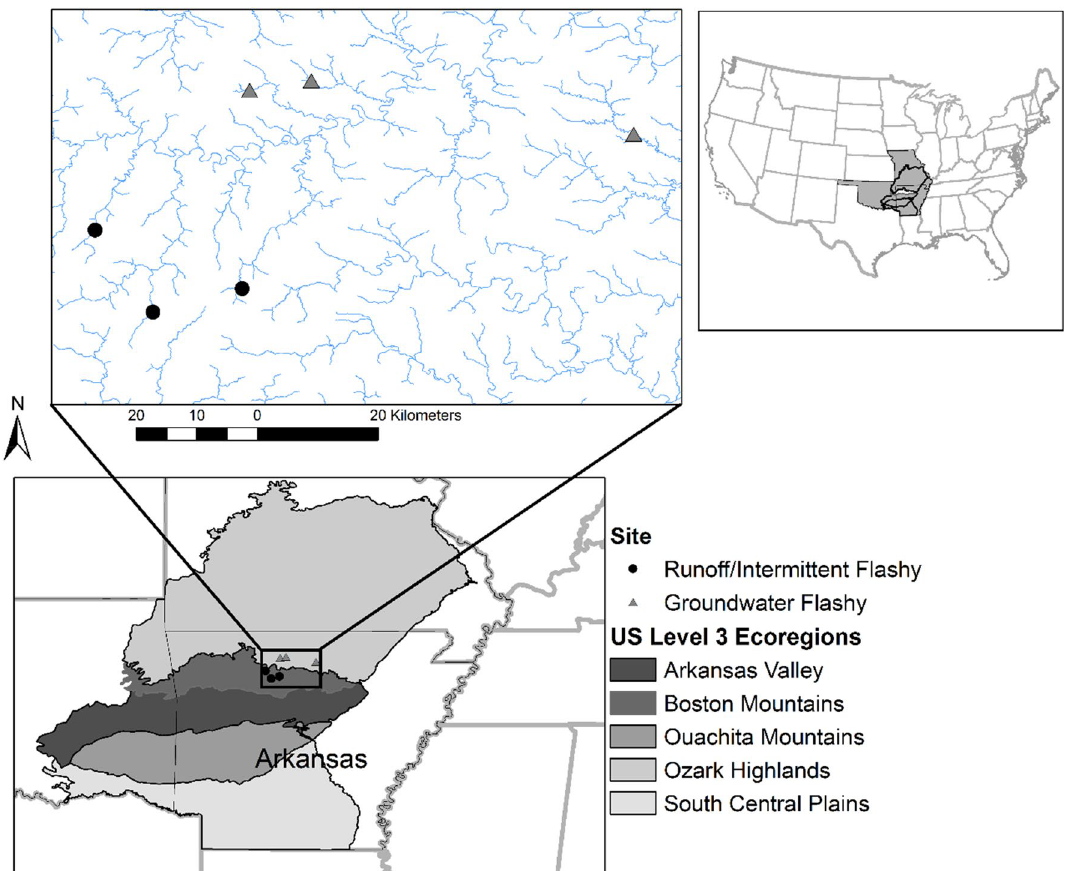
Figure 1. Map of study sites in Arkansas showing Runoff/Intermittent Flashy and Groundwater Flashy streams. Ecoregion boundaries also are displayed. Base map is GCS WGS84. Figure produced with ArcGIS 10.5.1